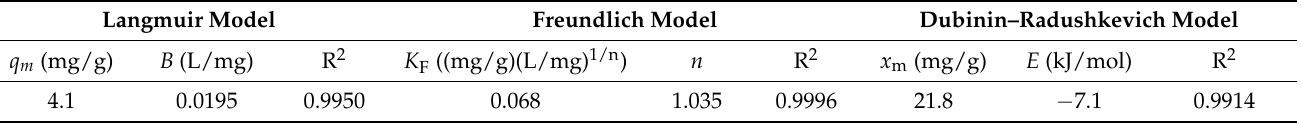
Table 3. Langmuir, Freundlich, and Dubinin–Radushkevich isotherm parameters for boron sorption on the Mn-biosorbent hydrogel beads at 20 ± 1 ◦ C. Langmuir